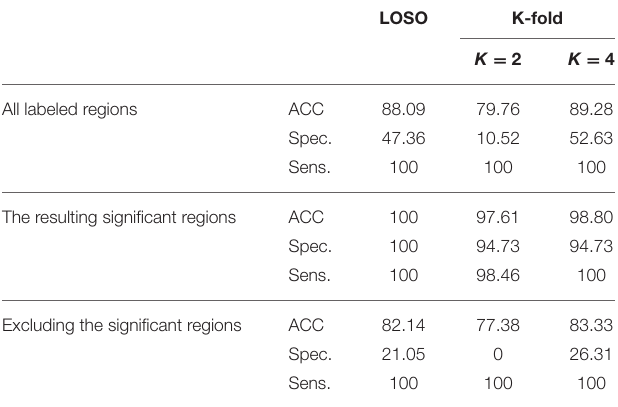
TABLE 4 | The comparison of the proposed system’s performance results, in %, TABLE 3 | Using LOSO and K-fold cross-validation methods to evaluate the against other related studies using LOSO cross-validation method. classification results, in %, (using linear-pSVM linear-SVMs) using the features of different cases of input regions: all the labeled regions, all the regions except the ACC significant ones, and the significant regions only. LOSO K-fold K = 2 K = 4